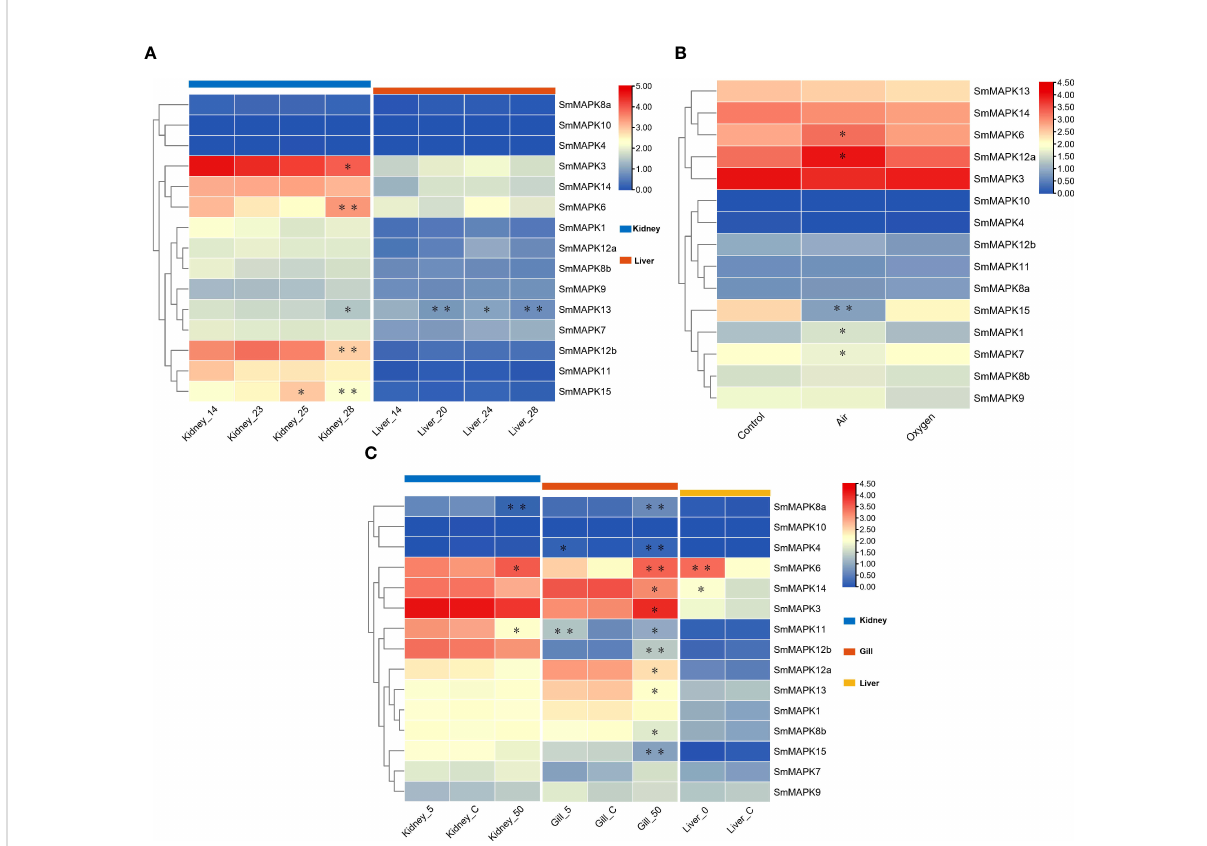
FIGURE 5 Heat map of mitogen-activated protein kinase (MAPK) expression in Scophthalmus maximus under three abiotic stresses. (A) Expression of MAPKs in kidney and liver tissues under heat stress: 14 °C: control group; 20 °C, 23 °C, 24 °C, 25 °C, and 28 °C: heat stress group. (B) Expression of MAPKs in gill tissues under oxygen stress: Control: 6.5 mg/L of O 2 , water; Air: 300 mg/L of O 2 , waterless; and oxygen: 1,430 mg/L of O 2 , waterless. (C) Expression of MAPKs in kidney, gill, and liver tissues under salinity stress: Control: 30 ‰ salinity (natural seawater); 50: 50 ‰ salinity; 5: 5 ‰ salinity; and 0: fresh water. Each cell with a different color corresponds to a different expression level, which was normalized into log 2 (FPKM + 1). *Signi fi cantly differentially expressed MAPKs with P < 0.05. **Extremely signi fi cant differential expression of MAPKs with false discovery rate (FDR) < 0.01 and |log 2 fold change (FC)| >